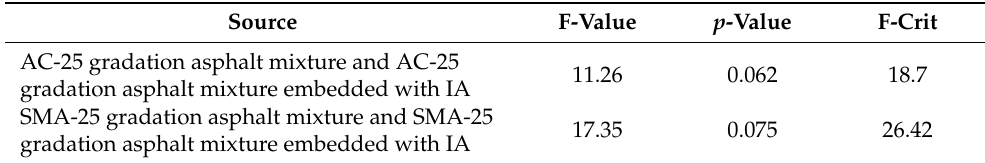
Table 10. Difference analysis of the dynamic modulus of two asphalt